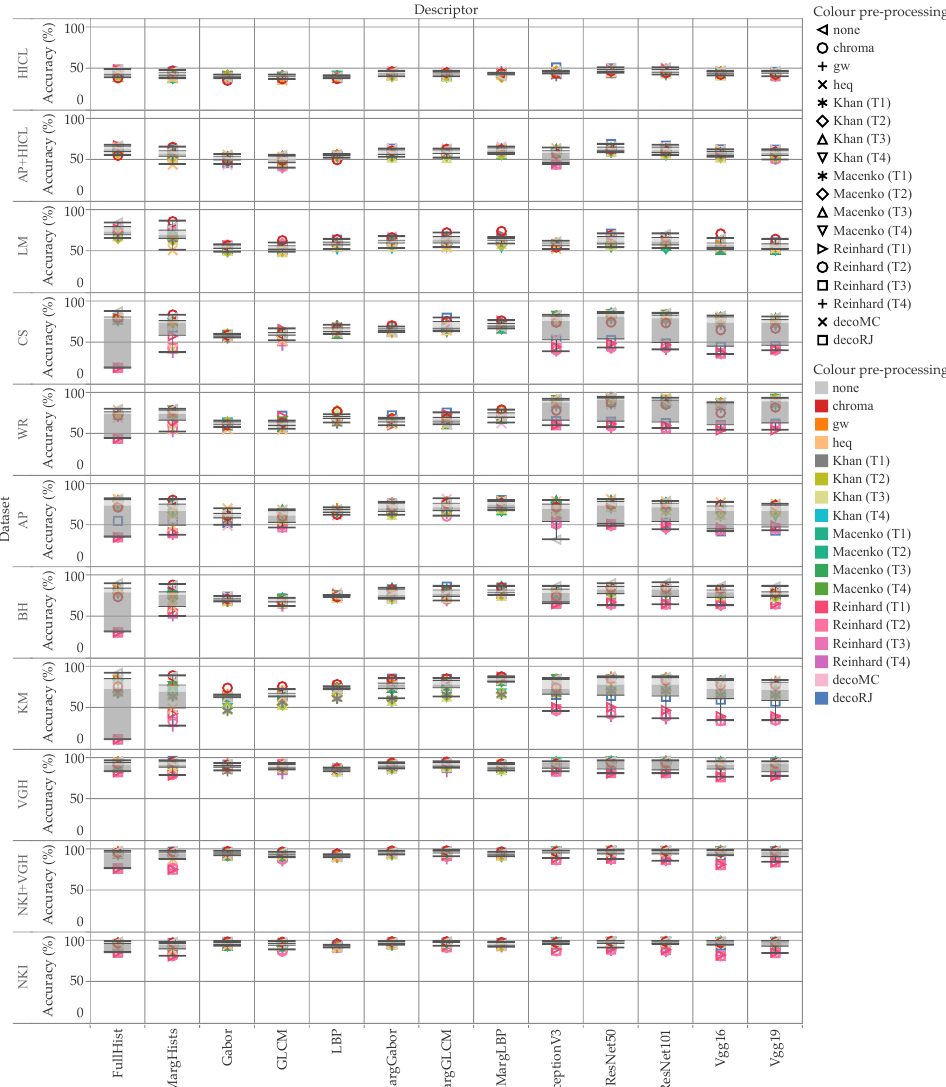
Figure 6. Accuracy by data set and descriptor; color indicates the pre-processing method. The values reported are for f = 4. This chart shows interesting things. First, texture-based image descriptors (e.g., LBP) are much more insensitive to color pre-processing than the other methods (e.g., FullHist). This is important when analyzing the reproducibility of the methodologies. Second, the cases where there was large variation seemed to have results on the extremes (i.e., KM / FullHist) and not a uniform distribution. Third, and perhaps the most important, the accuracy obtained in different datasets is considerably different. Compare for instance NKI which is very close to 100% with LM where most cases are around 50%. This highlights the importance of testing on more than one dataset, as the choice of dataset can result in higher or lower values of